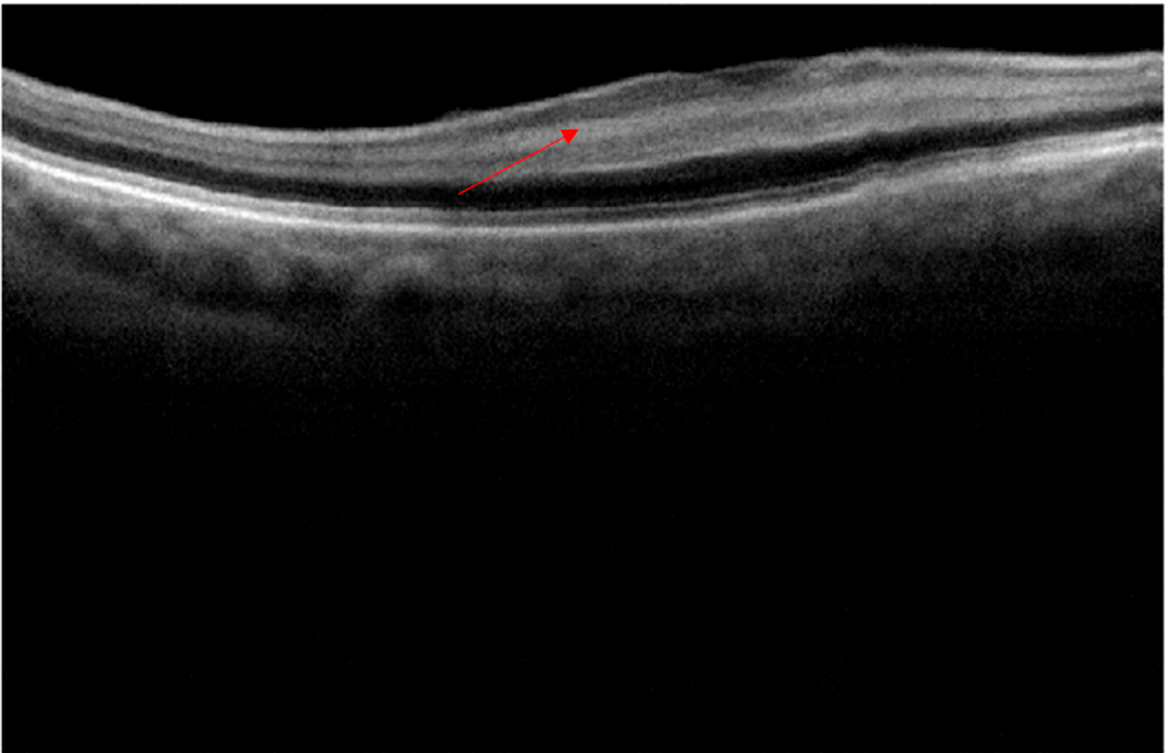
Figure 2. Day one postoperative OCT cross section showing total loss of the negatively enhancing inner nuclear layer, replaced by a highly reflective band marked by a red arrow.